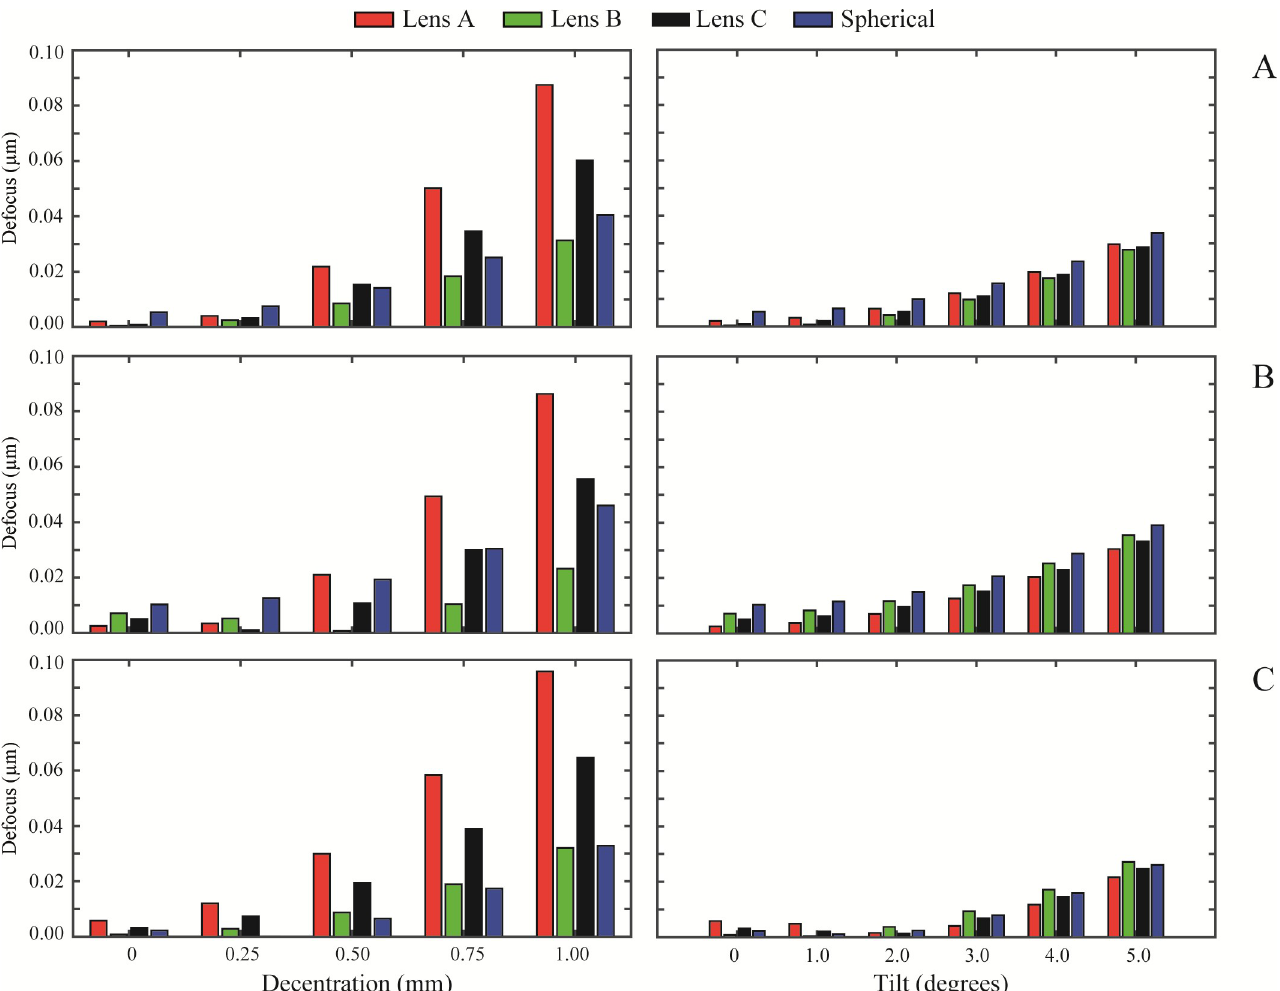
Fig 2. RMS defocus ( Z 0 ) values of the designed IOLs for misalignment (left column) and tilt (right column) with each different cornea: A) Normal, B) Myopic, 2 C) Hyperopic.